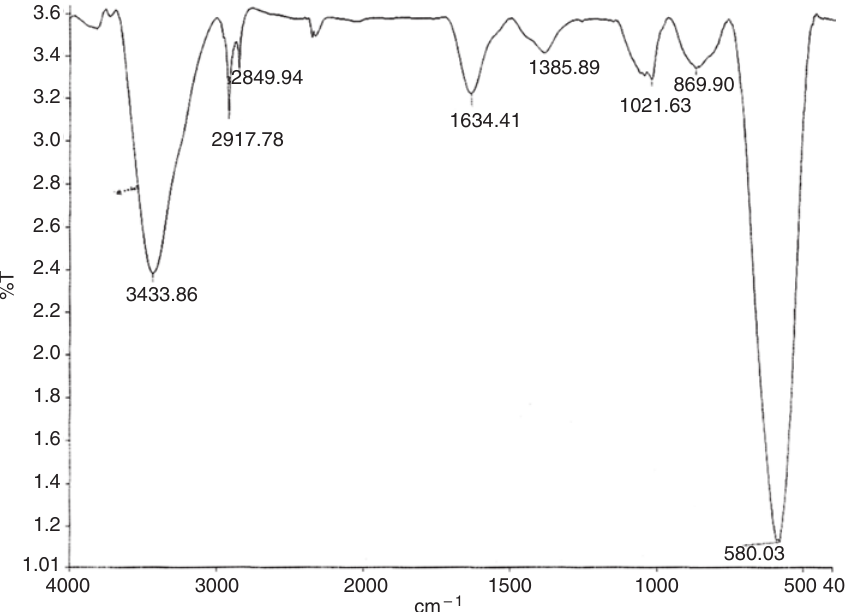
Figure 1: Infrared spectrum of MnNPs synthesized using methanolic extract of Phyllanthus amarus .